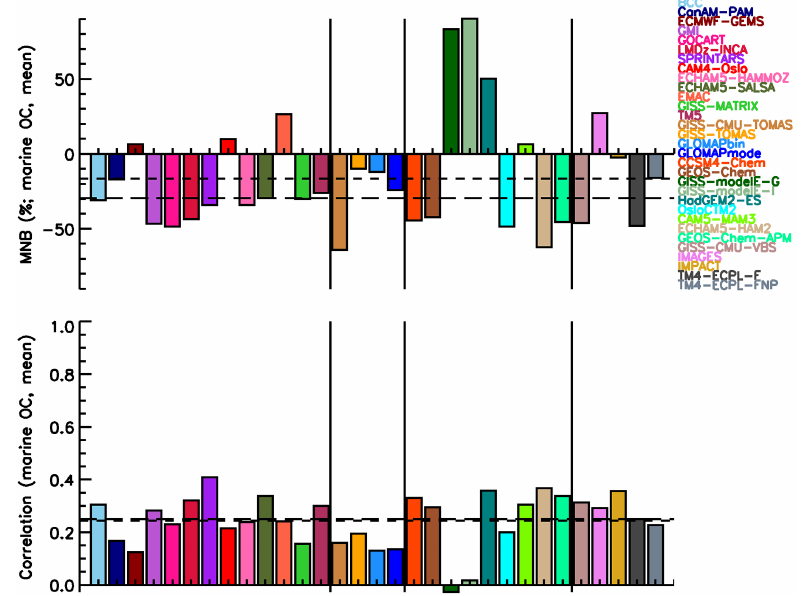
Figure 14. Same as Fig. 10, for marine OC